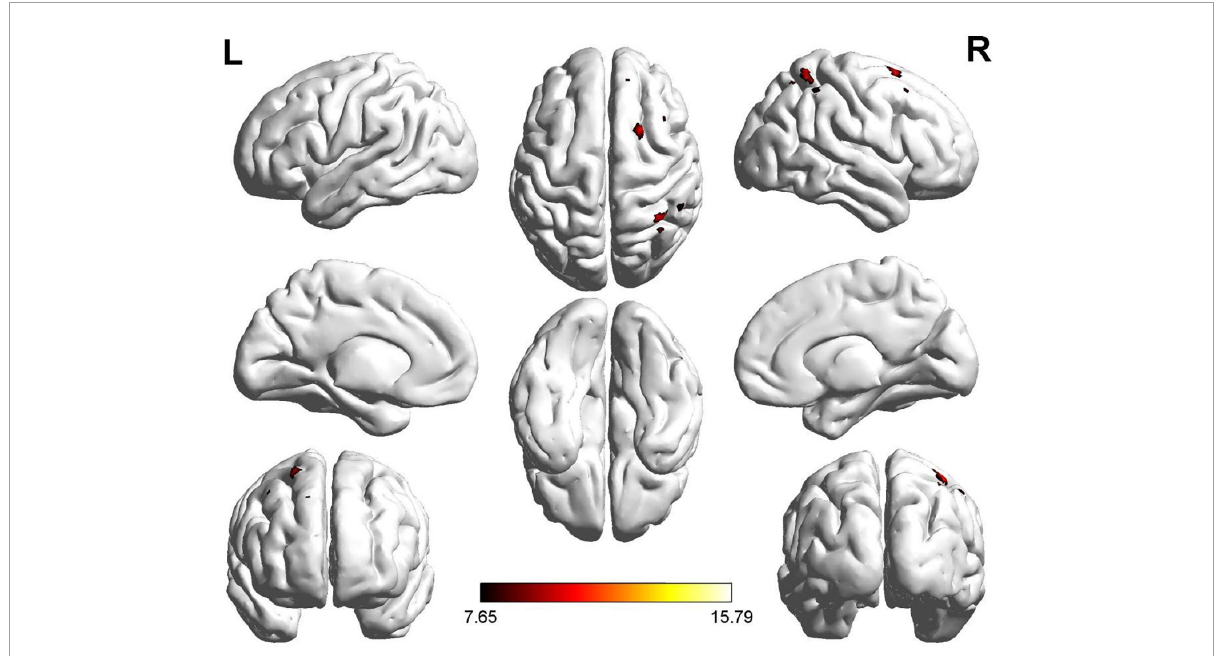
FIGURE3 Significant FC patterns between the ROIs (dorsolateral SFG, left) and right SFG, left medial superior frontal gyrus (SFG), and right superior parietal gyrus (SPG) in the recent-onset tinnitus (ROT) and persistent tinnitus (PT) groups compared to the healthy control group.